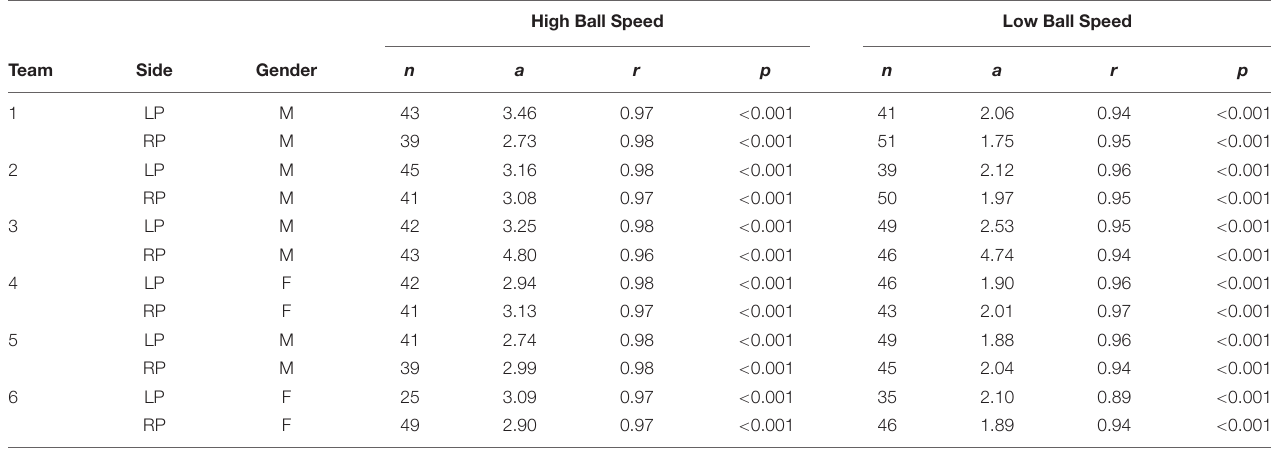
TABLE 4 | Results of regression analyses of the relations between peak velocity and distance covered during movements resulting in interception, performed for each participant separately for each of the two vertical ball